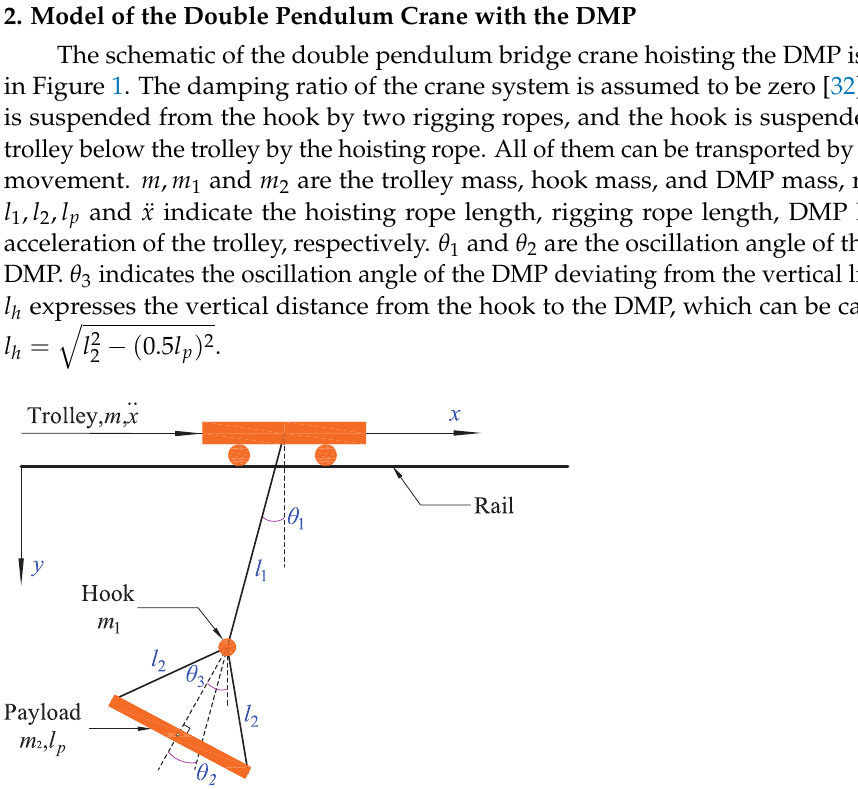
Figure 1. Model of the double pendulum bridge crane hoisting the